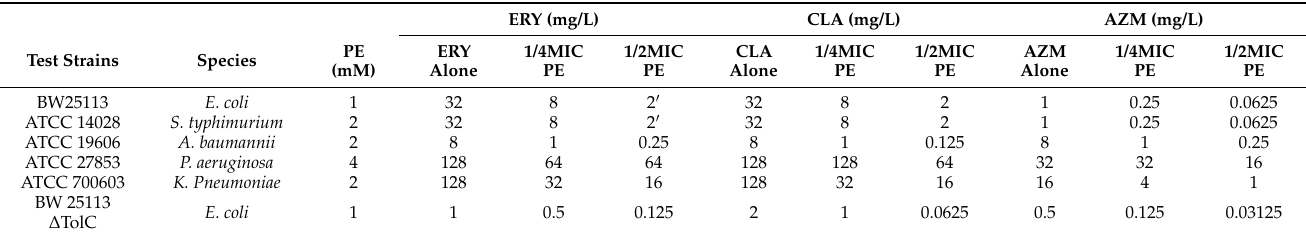
Table 1. MICs of Erythromycin, clarithromycin, azithromycin, and phentolamine alone, MICs of Ery- thromycin, clarithromycin, azithromycin in the presence and absence of 1/4-1/2 MIC